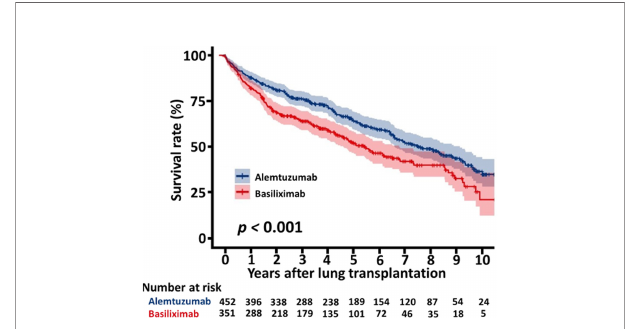
FIGURE 2 | Kaplan-Meier curve for patients survival.